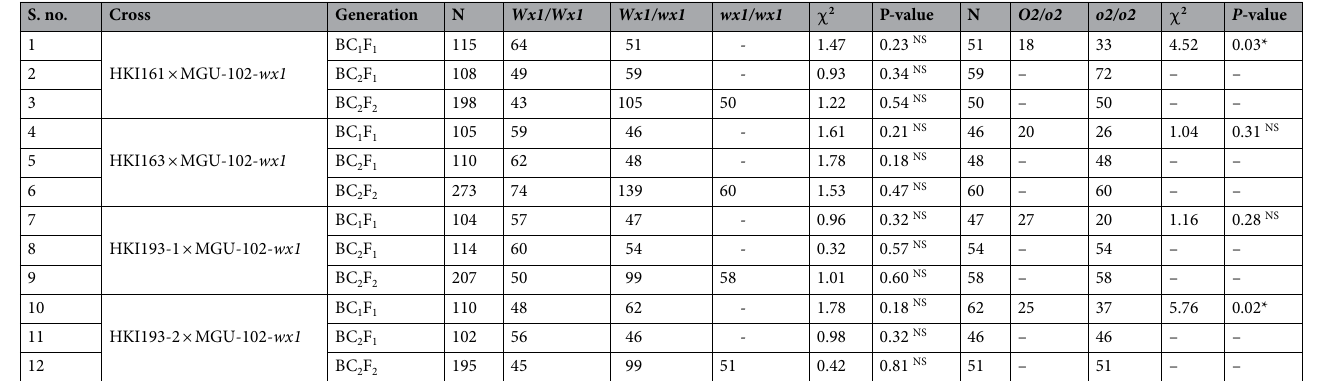
Table 2. Segregation pattern of wx1 and o2 in different backcrosses and self-generations. *Significant at P = 0.05. ns non-significant, N No. of plants genotyped, df degrees of freedom, Wx1, dominant allele; wx1, recessive allele; O2 , dominant allele; o2 , recessive